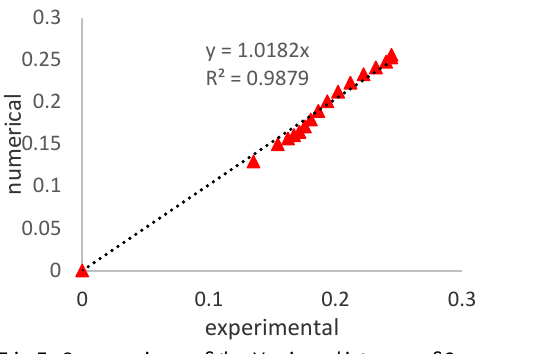
in a distance of 10 cm x from the